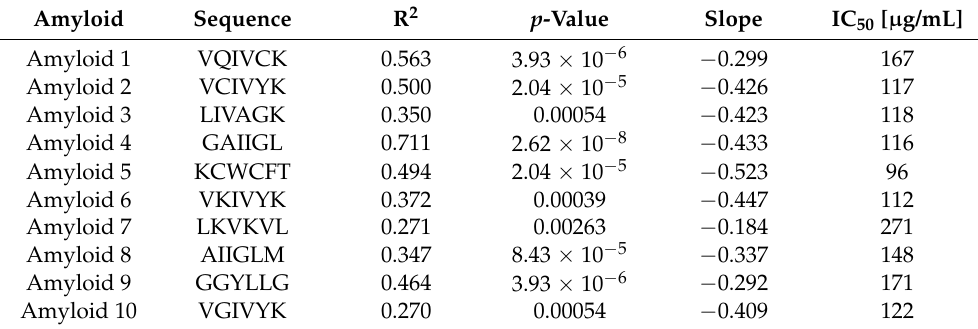
Table 2. Parameters of regression analyses for viability of the HEK-293 cells subjected to ten amy- loids and IC 50 values calculated on the basis of the obtained models. R 2 states for coefficient of